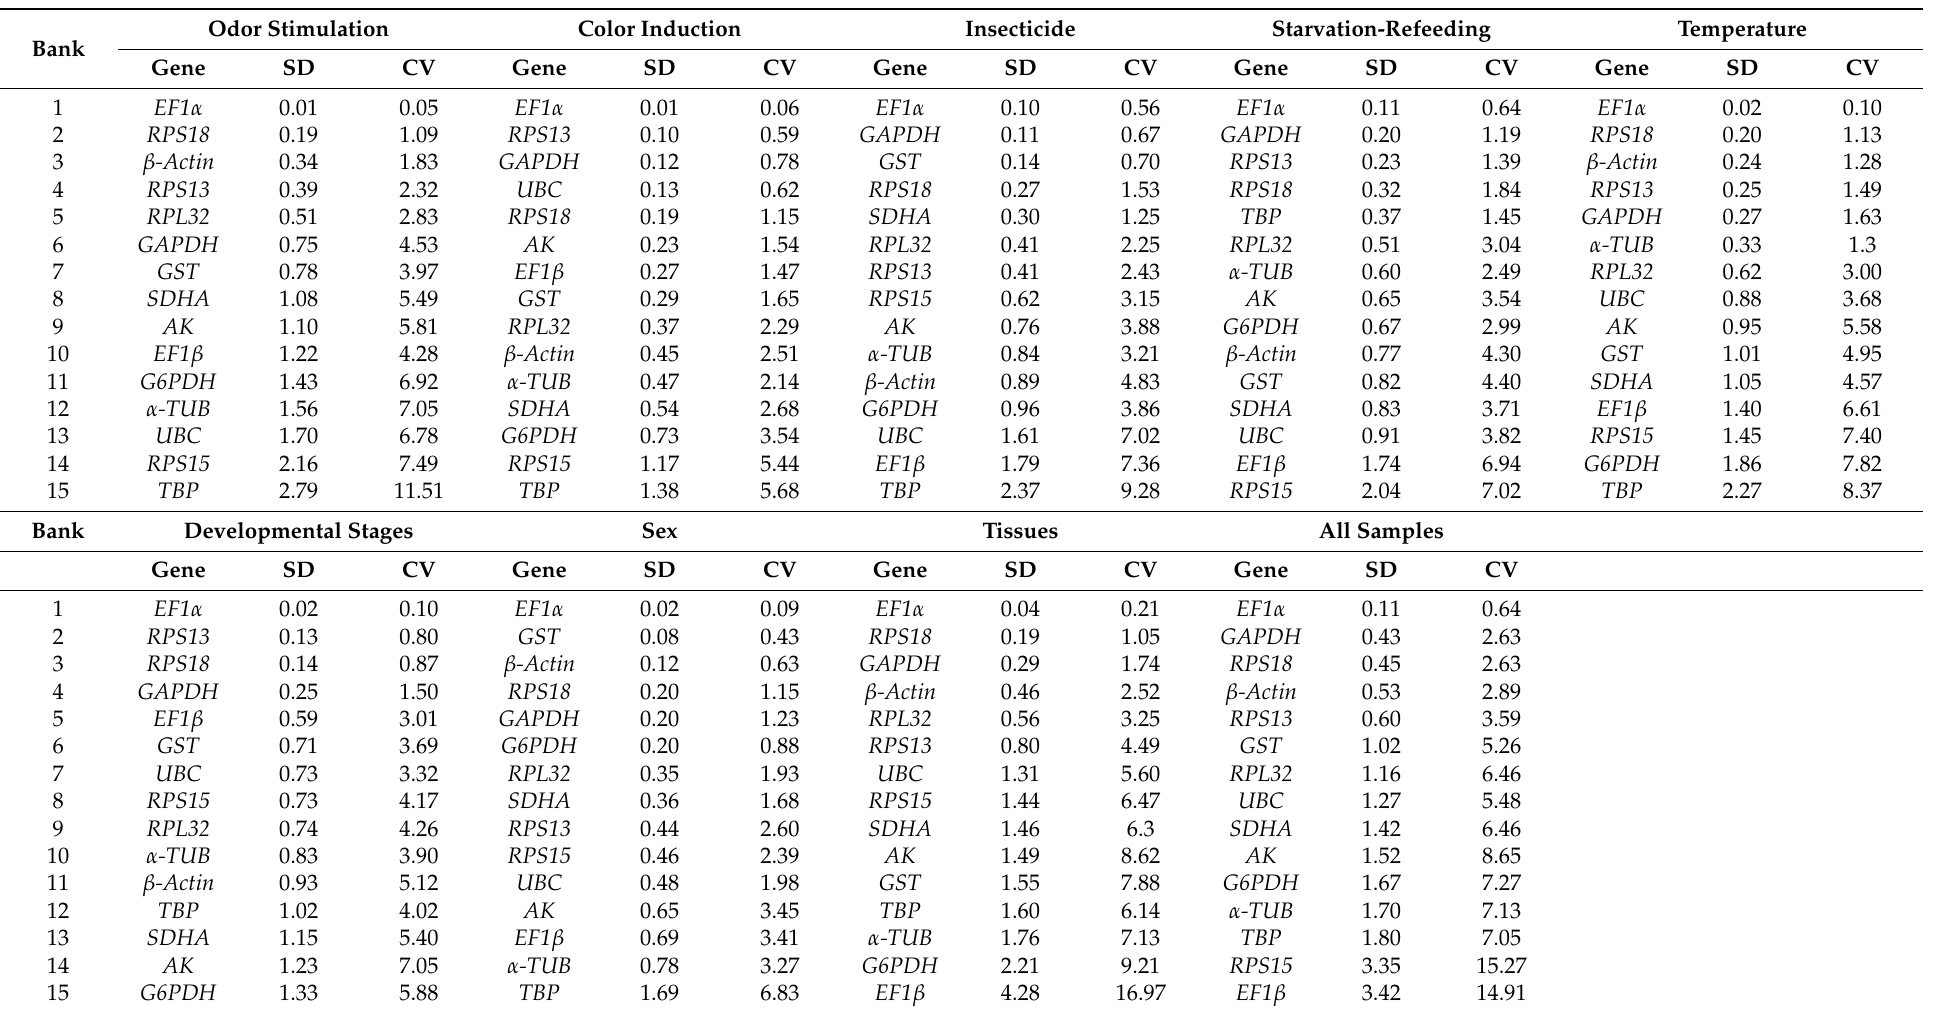
Table 3. Stability analysis of 15 candidate reference genes based on BestKeeper software. The standard deviation (SD) and coefficient of variation (CV) were given (the lower, the more stable). The stability decreased from top to